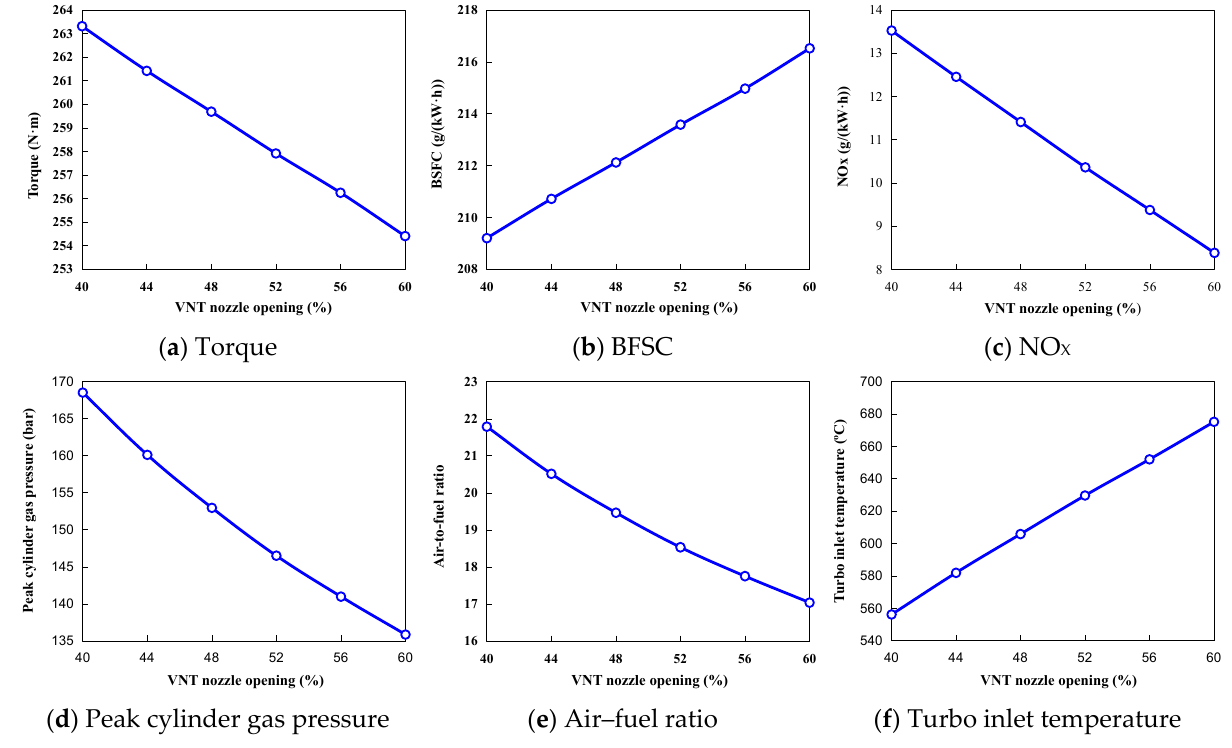
Figure 9. Effects of VNT valve opening on the performance and emission of a diesel engine.